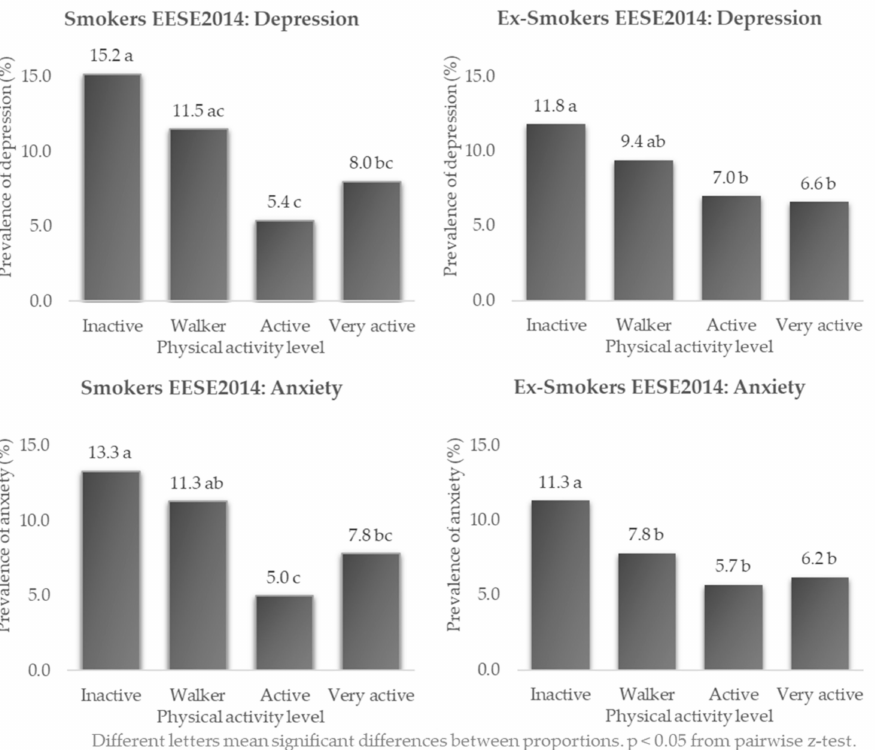
Figure 4. Prevalence of depression and anxiety in Spanish smokers and ex-smokers according to their frequency of physical activity: